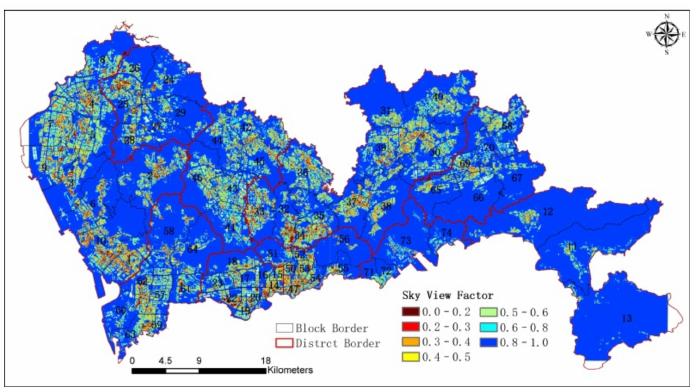
Figure 13. SVF distribution in